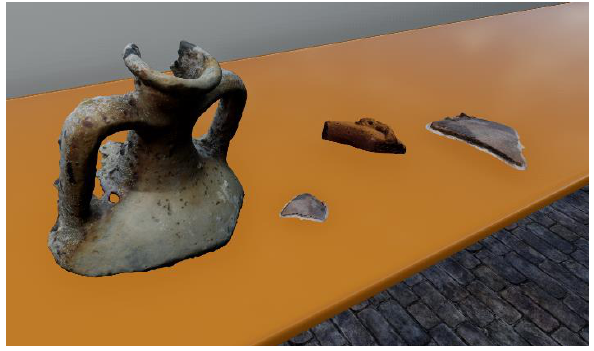
Figure 18. Texture detail – inside